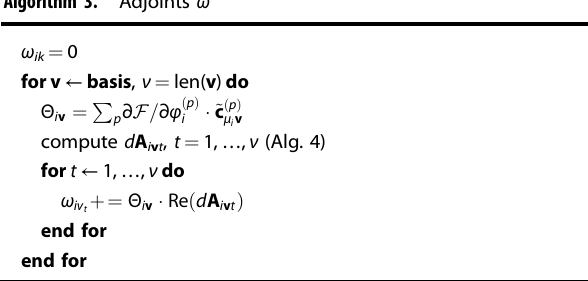
Algorithm 3. Adjoints